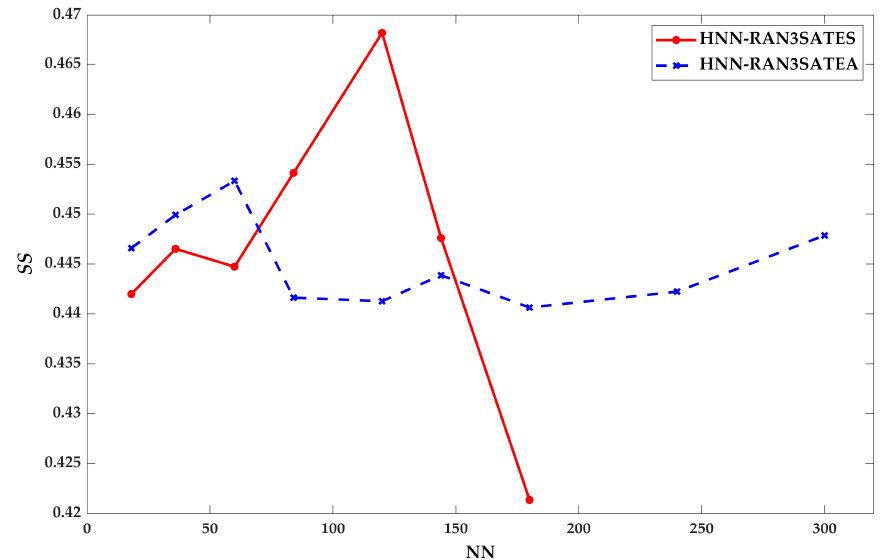
Figure 11. SS (Sokal Sneath) for HNN-RAN3SAT model.